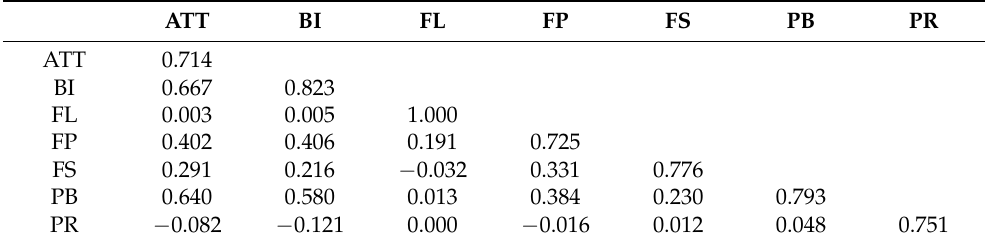
Table 4. Fornell–Larcker